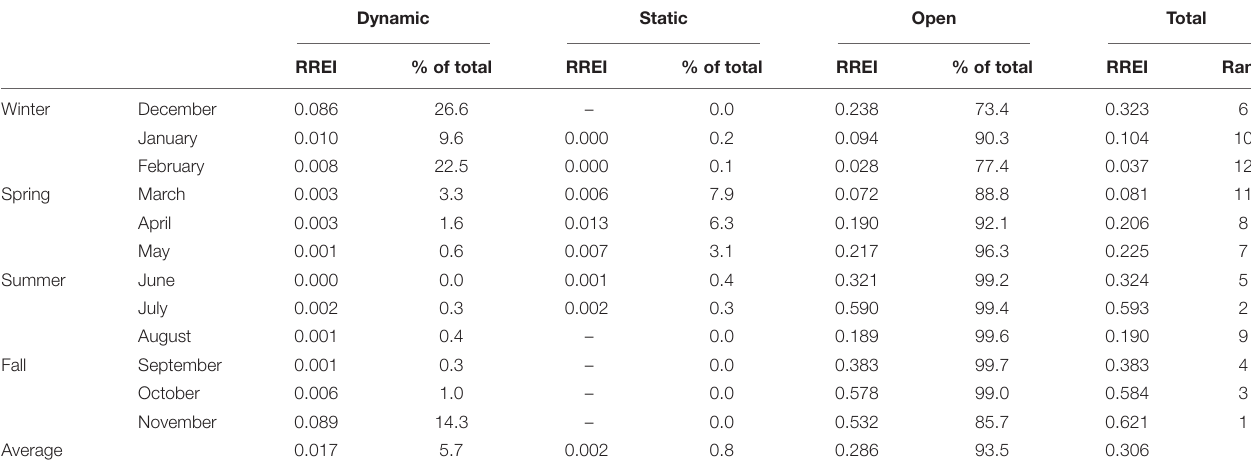
TABLE 5 | Average monthly Relative Risk of Entanglement Index (RREI) for dynamic and static whale-modified-gear management areas, open areas, and total for the area north of 40-degree north latitude from shore east to the Exclusive Economic Zone, for April 2002 to March 2009. Dynamic